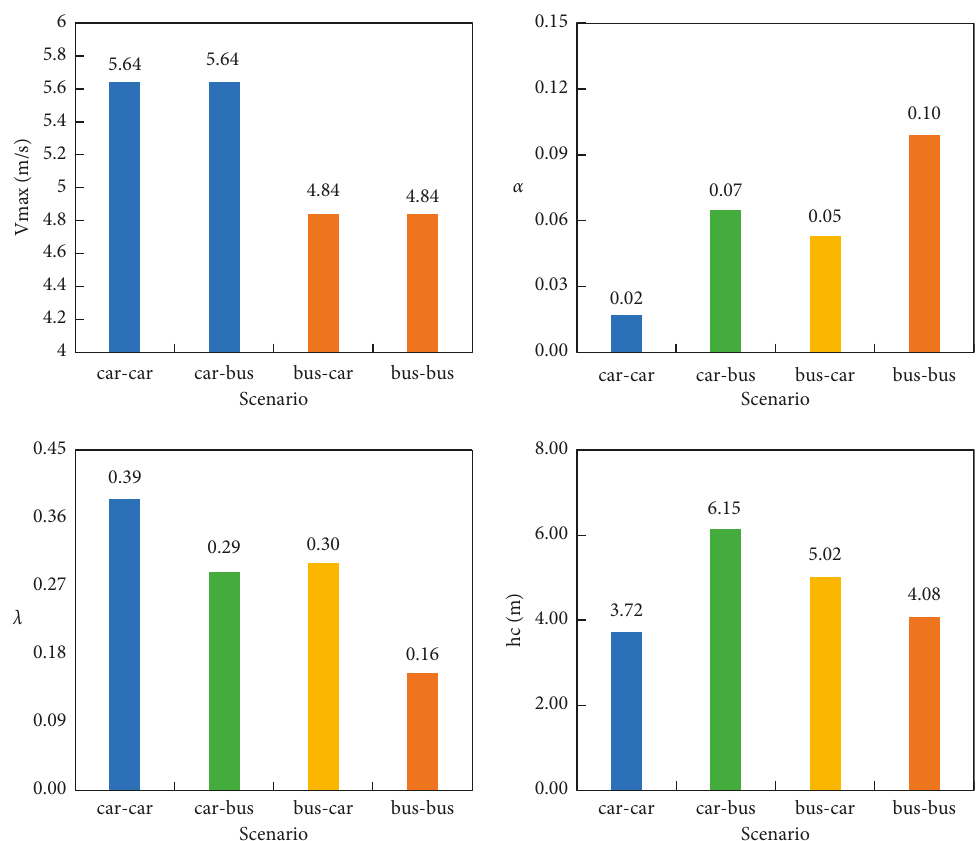
Figure 15: Calibrated parameters of proposed car-following model in different scenarios.